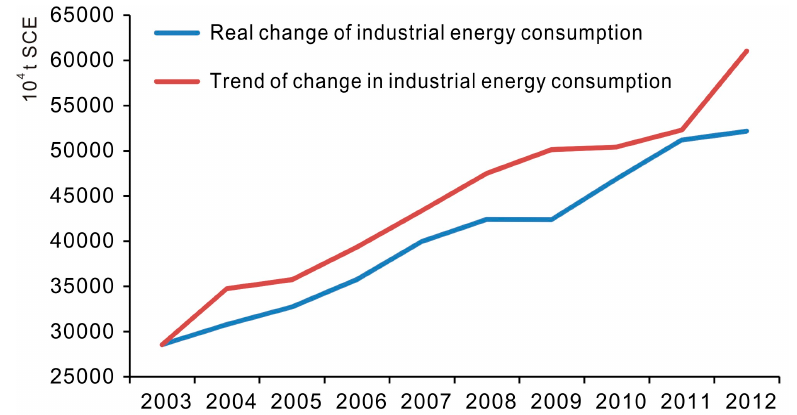
Figure 3. Real change and trend of change in industrial energy consumption 2003–2012.